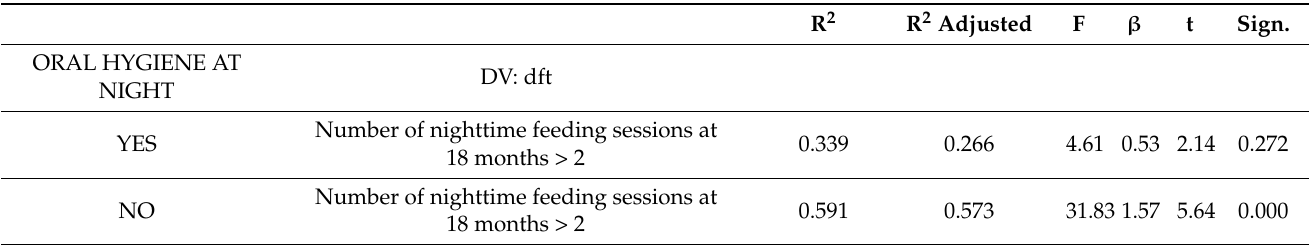
Table 2. Prediction of the dft index from the number of nighttime feeding sessions at 18 months (>2) for the subjects who received oral hygiene at night and those who did not receive oral hygiene at night. R 2